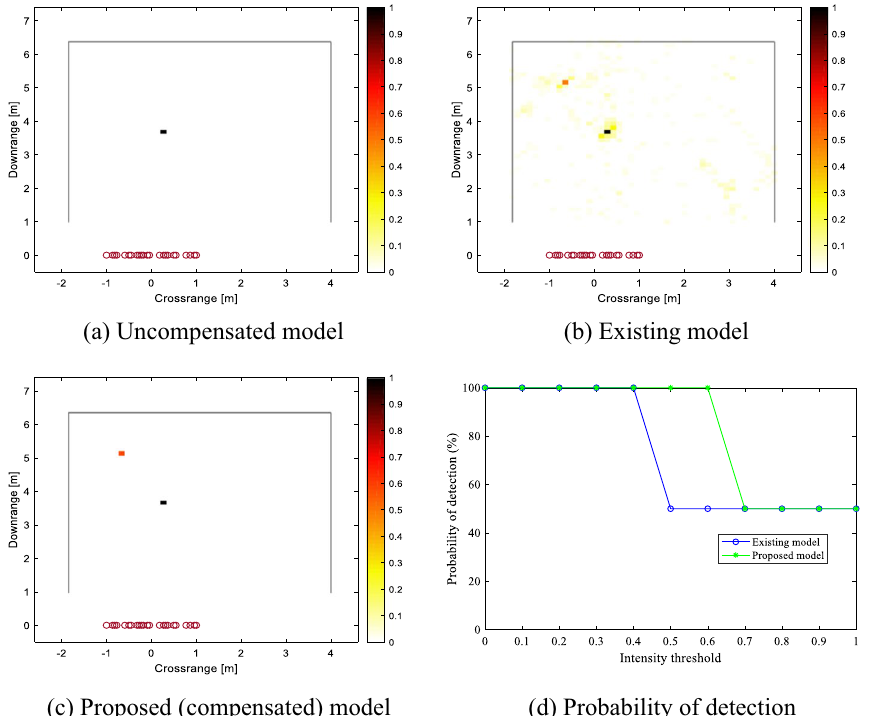
Fig. 6 Images from sparse reconstruction with known number of